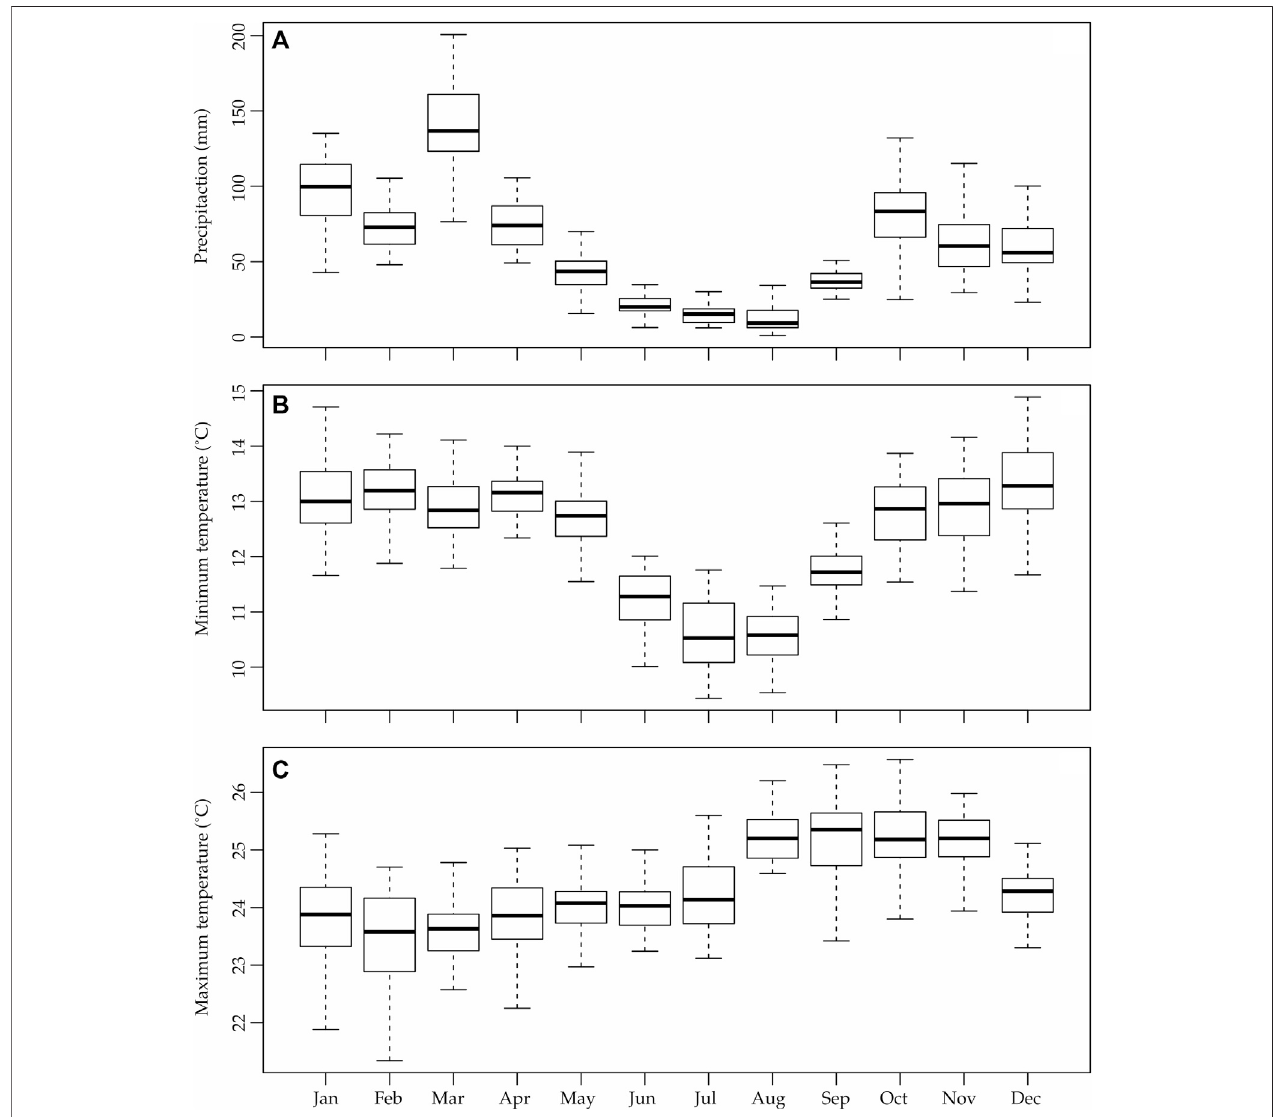
FIGURE2| Annualbehaviorofrainfall (A) ,minimumtemperature (B) andmaximumtemperature (C) inthecityofChachapoyas.Theupperwhiskerofeachboxplot indicatesthemaximumvalueofeachparameterineachmonth,whilethelowerwhiskerindicatestheminimumvalueofeachparameterineachmonth,fortheentiredata series from January 1981 to December